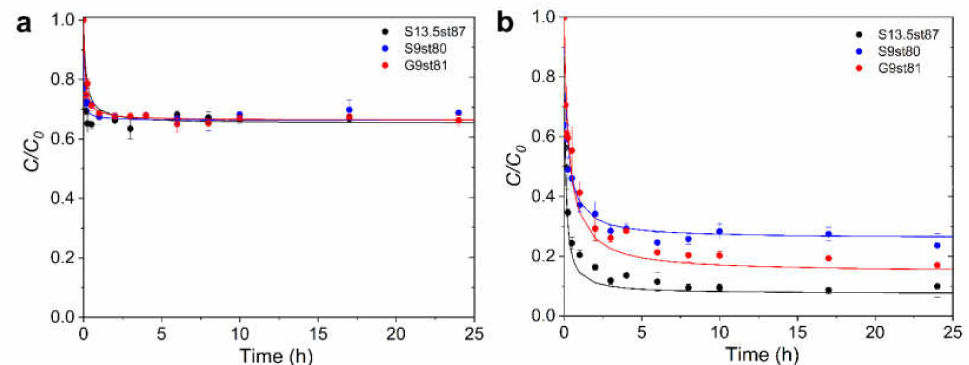
Figure 9. Adsorption kinetics of ibuprofen ( a ) and iopamidol ( b ) onto activated carbon samples (experimental conditions: temperature 30 ◦ C, initial concentration 180 mg L − 1 , volume 30 mL, and weight of activated carbon 6